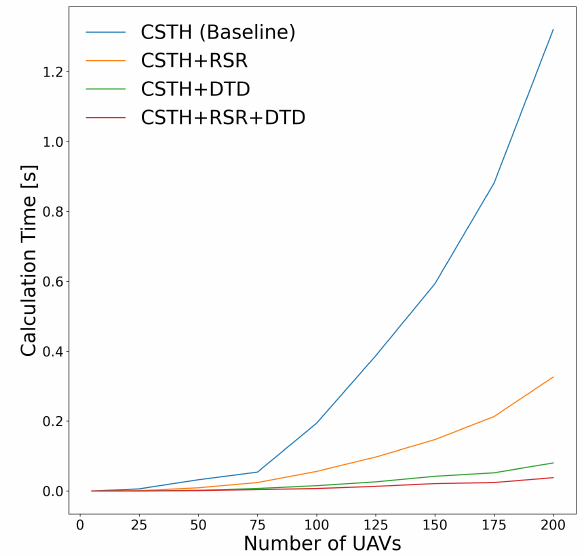
Figure 17. Calculation time for the matrix formation when varying the number of UAVs in the